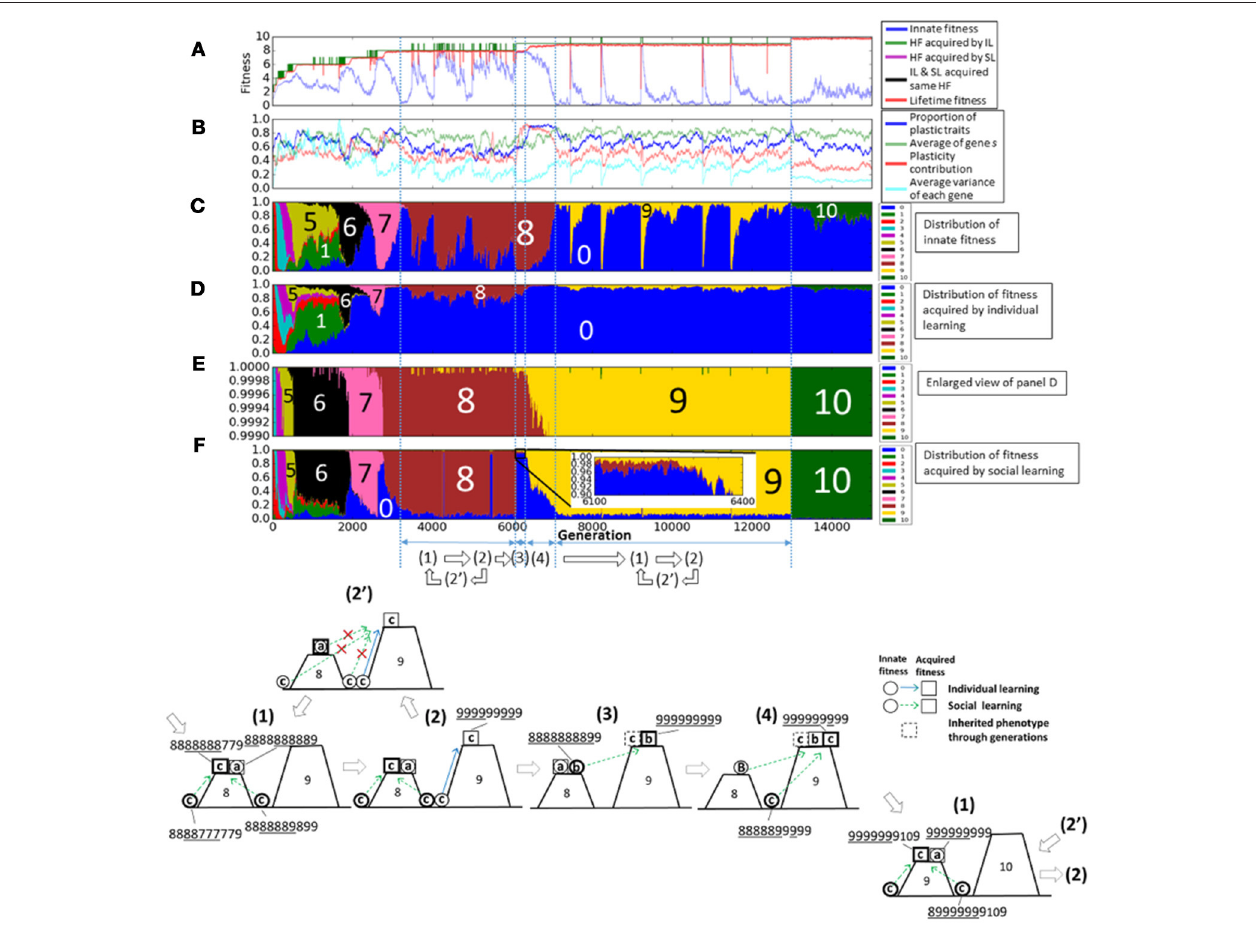
FIGURE 6 | The evolution of the population with individual and social learning. (A) Shows the initial and highest and lifetime fitness, and (B) shows the proportion of plastic traits, plasticity contribution and average variance of each gene. (C) Shows the distribution of the innate fitness. (D) Shows the distribution of acquired step fitness by individual learning, and (E) shows the enlarged view of (D) . (F) Shows the distribution of acquired step fitness by social learning. (1–4) illustrate typical phases of the evolution of the population on the rugged fitness landscape, each corresponds to the duration indicated by a double headed arrow. Each individual is represented as a pair of a circle, showing its innate fitness, and a square showing its lifetime fitness. The dotted square showing inherited phenotypes through generations. The circle and the square are connected with a directional arrow, representing its learning process. Blue arrow represents individual learning and green arrow represents social learning. Thick circles and squares represent dominant individuals in the